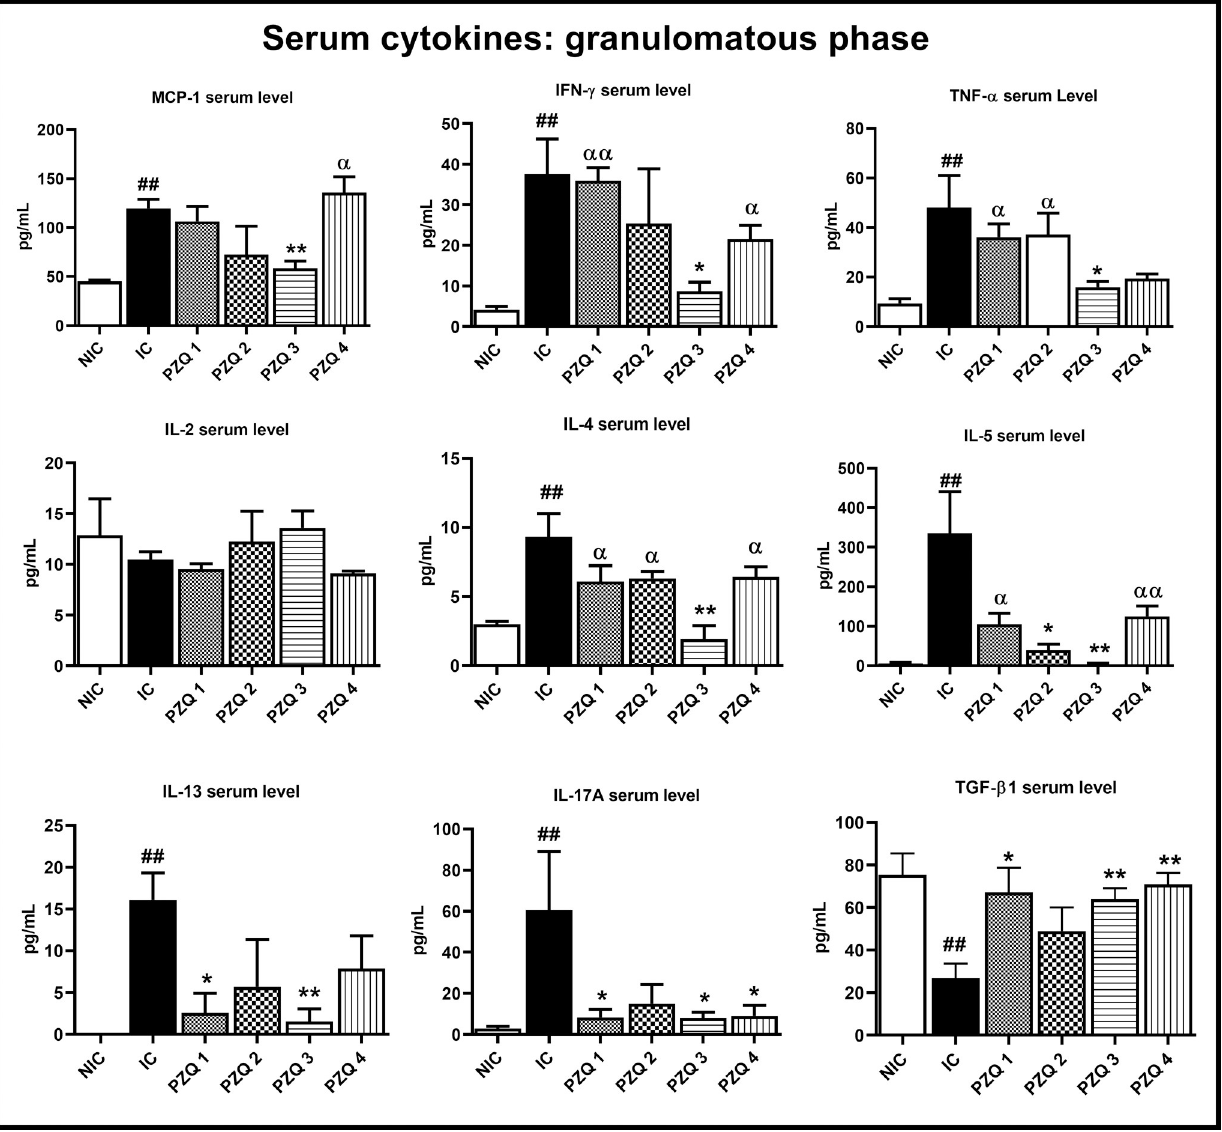
Fig 11. Effect of praziquantel treatment on the serum cytokines levels during the granulomatous stage of Schistosoma mansoni infection in mice. HC: Uninfected mice, IC: Infected-untreated mice, PZQ1: Infected mice treated with praziquantel at 100 mg/kg for 5 consecutive days, PZQ2: Infected mice treated with praziquantel at 100 mg/kg for 28 consecutive days, PZQ3: Infected mice treated with praziquantel at 18 mg/kg for 28 consecutive days, PZQ4: Infected mice treated with a single dose of praziquantel at 500 mg/kg. Data are expressed as mean ± SEM (n = 6). ANOVA followed by Tukey multiple comparison test was also used for statistical analysis. ## p < 0.01: values are significantly different from those uninfected mice (group HC). � p < 0.05, �� p < 0.001: values are significantly different from those of infected-untreated mice (group IC). α p < 0.05, αα p < 0.01: values are significantly different from those of infected mice treated with PZQ3 posology (group